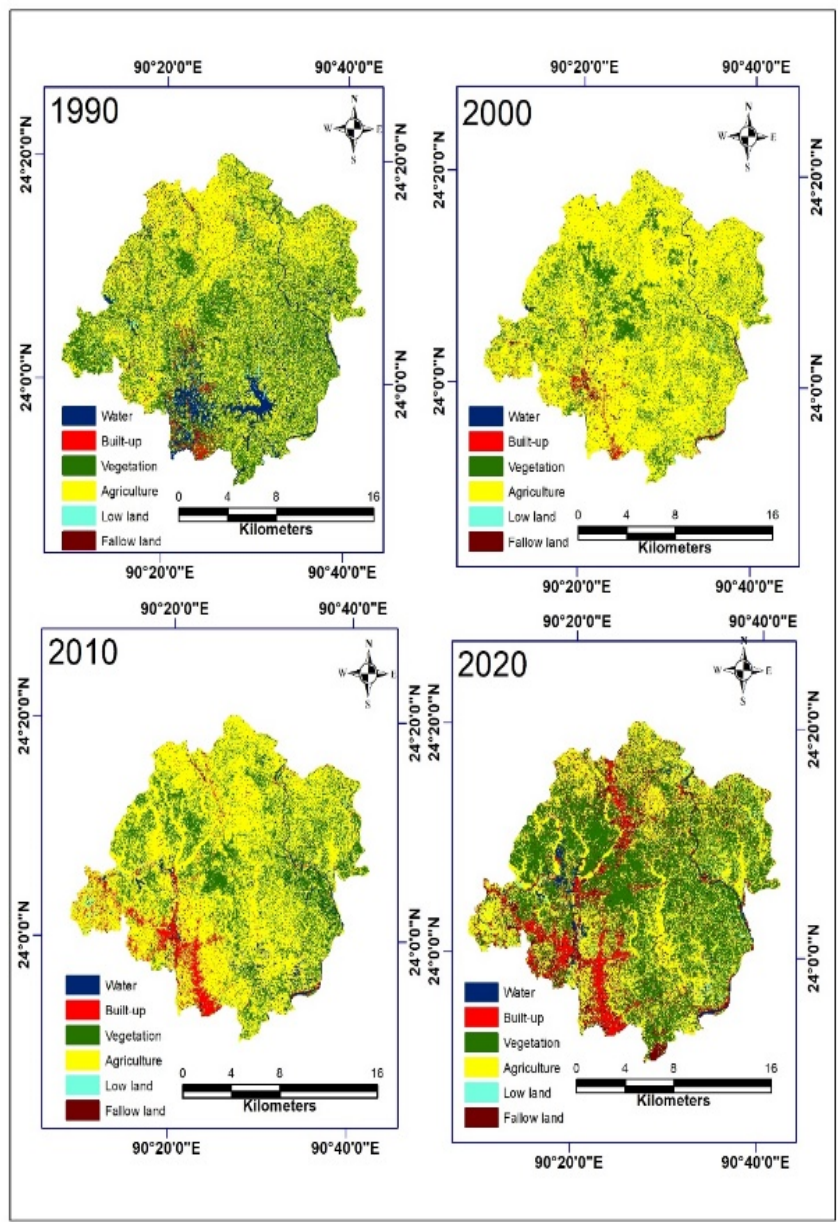
Figure 4. Land-use/land-cover map.